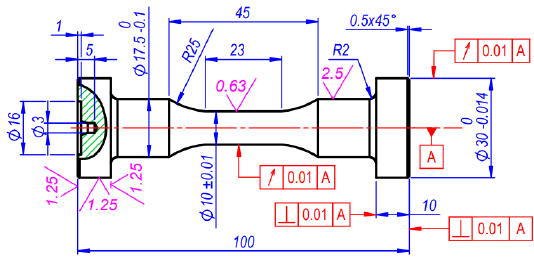
Figure 2. S pecimens for low-cycle fatigue experiments (units in mm).